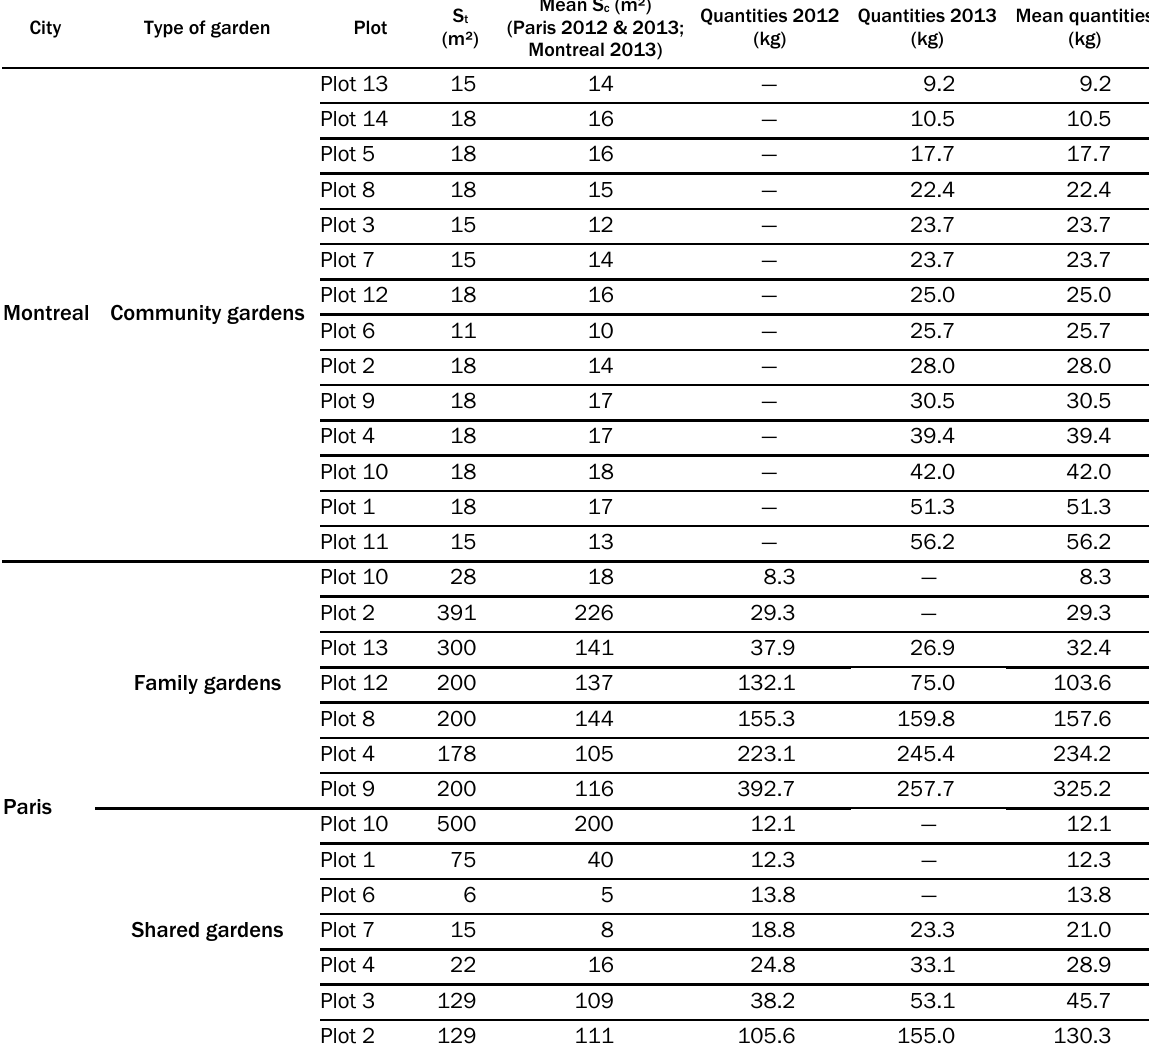
Table 1. Quantities of Fruits and Vegetables Harvested in Sampled Gardens